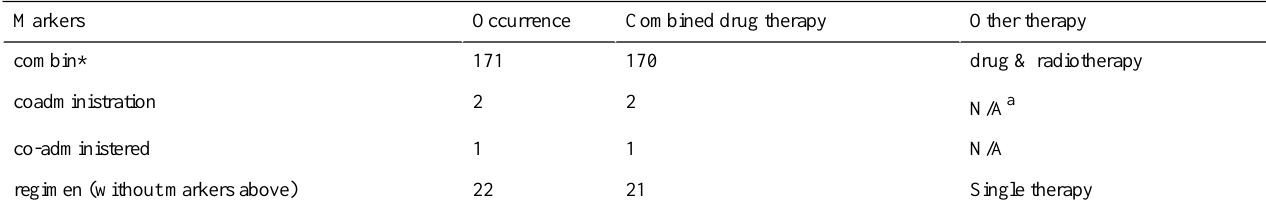
Table 5. Major makers to identify combined drug